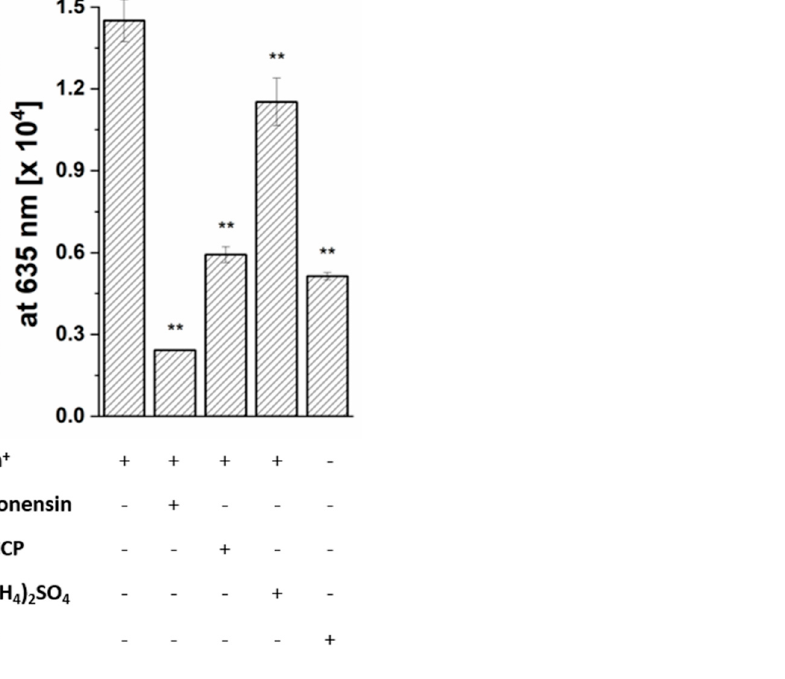
Figure 9. Effect of Na + and uncouplers on the membrane potential of P. bivia . The fluorescence emission of cells incubated under the indicated conditions was corrected by the emission of fluorophore in buffer. CCCP, carbonyl cyanide m-chlorophenylhydrazone. Mean values and averages from four technical replicates are shown. Asterisks (**) indicate significant differences from cells incubated with Na + in the absence of inhibitors with p < 0.05.